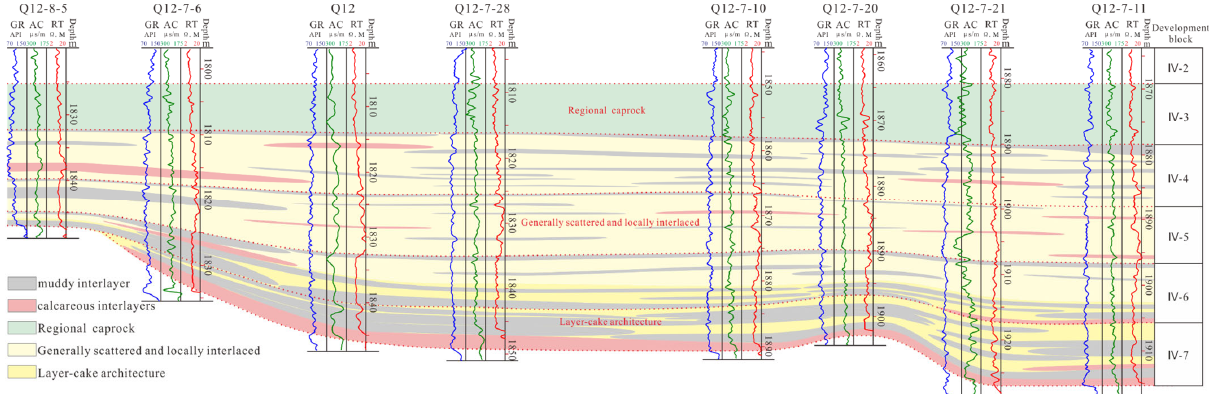
Figure 7. The interlayer distribution of the Qie12 block.